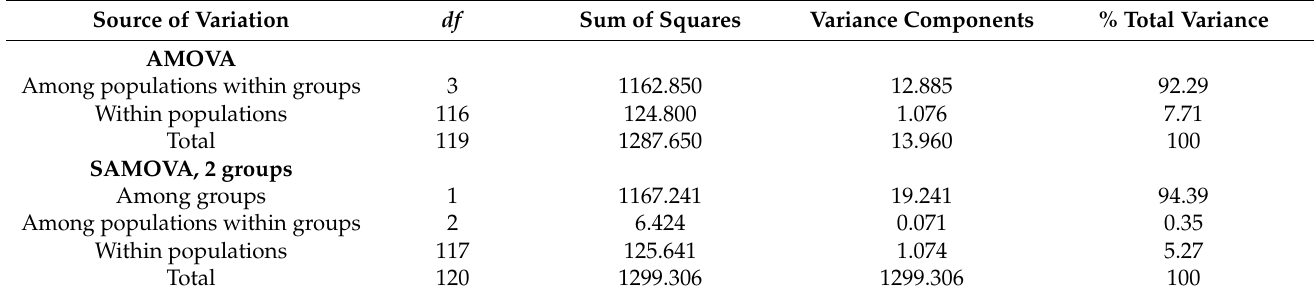
Table 3. Hierarchical analysis of molecular variance (AMOVA) and spatial analysis of molecular variance (SAMOVA) among populations of Batagur affinis